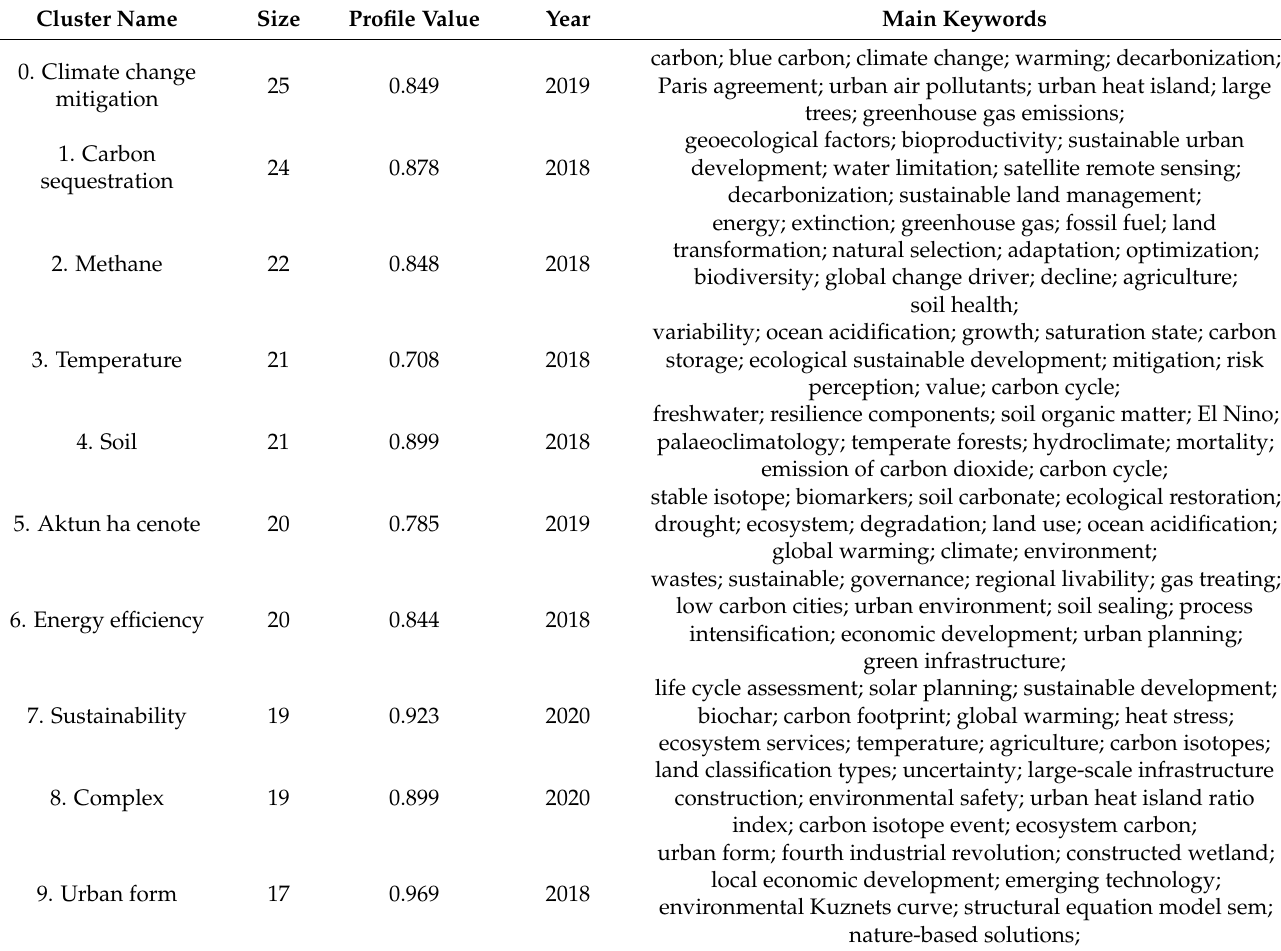
Table 5. Keyword clustering of RCHSCC in the last five